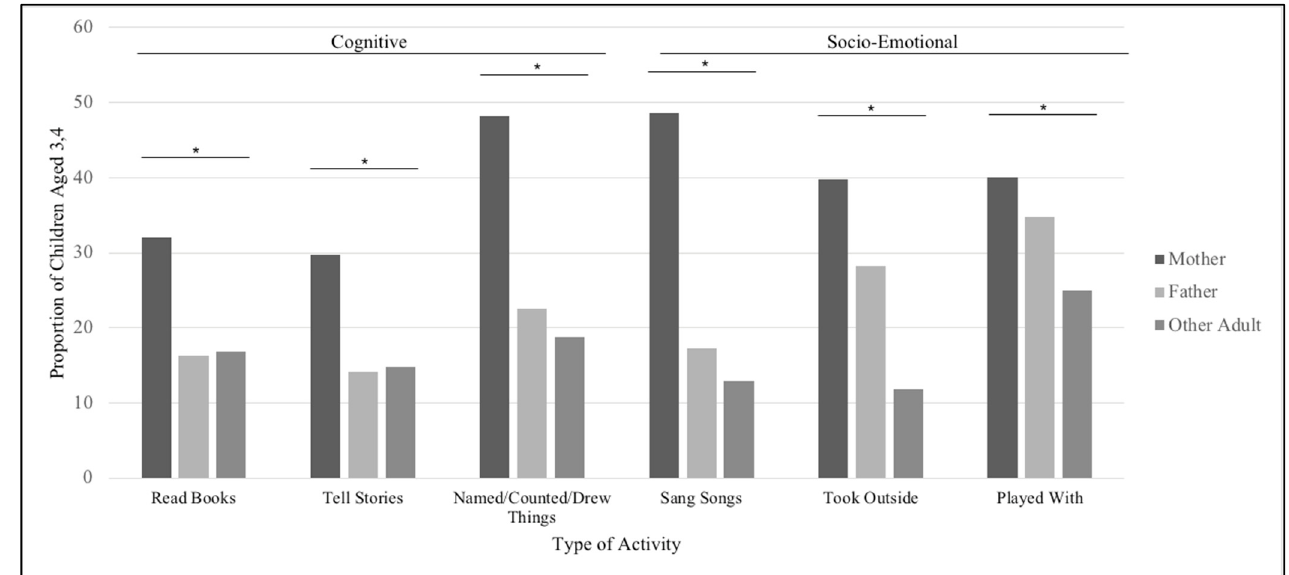
Figure 2. Proportion of children aged 3–4 who were engaged by a parent/adult in the three days prior to the survey by type of cognitive and socio-emotional activity. ‘Other adult’ refers to any adult aged 15 and over who is not the child’s father or mother and is a member of the household. * p < 0 .0001; obtained from Cochran’s Q tests comparing proportions between parents/adults for each type of activity.